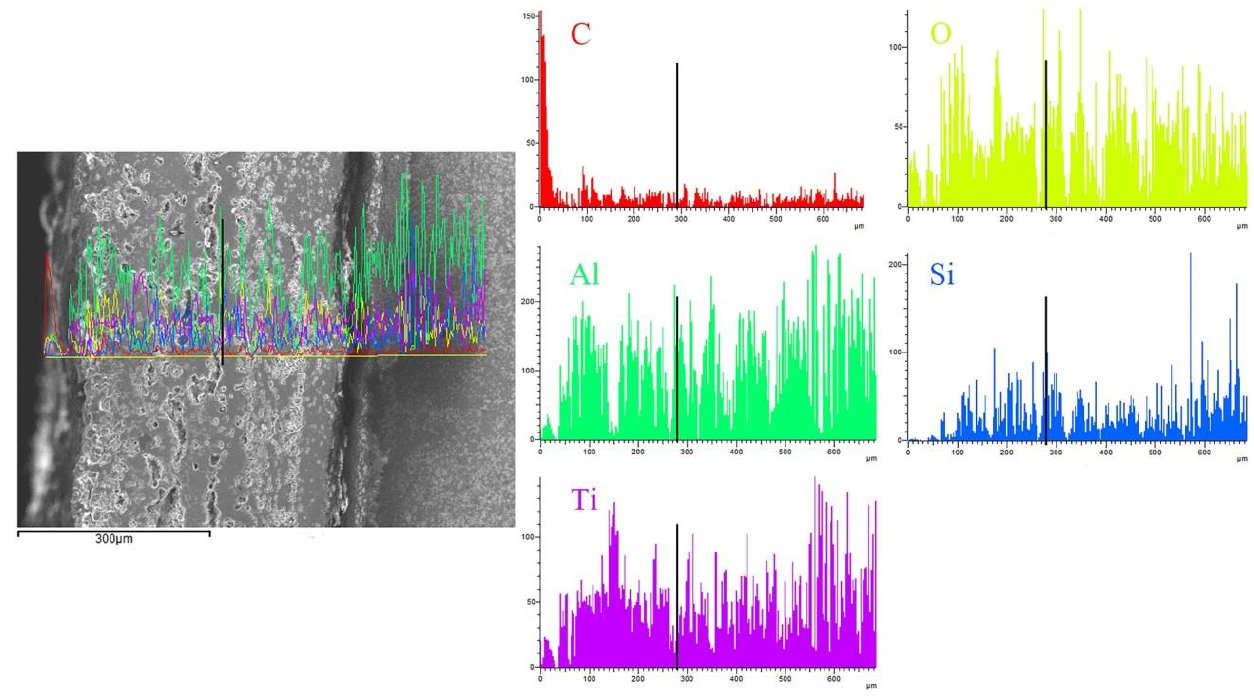
Figure 10. EDS line scanning results of TSC50 after oxidation at 1400 °C for 20 h.